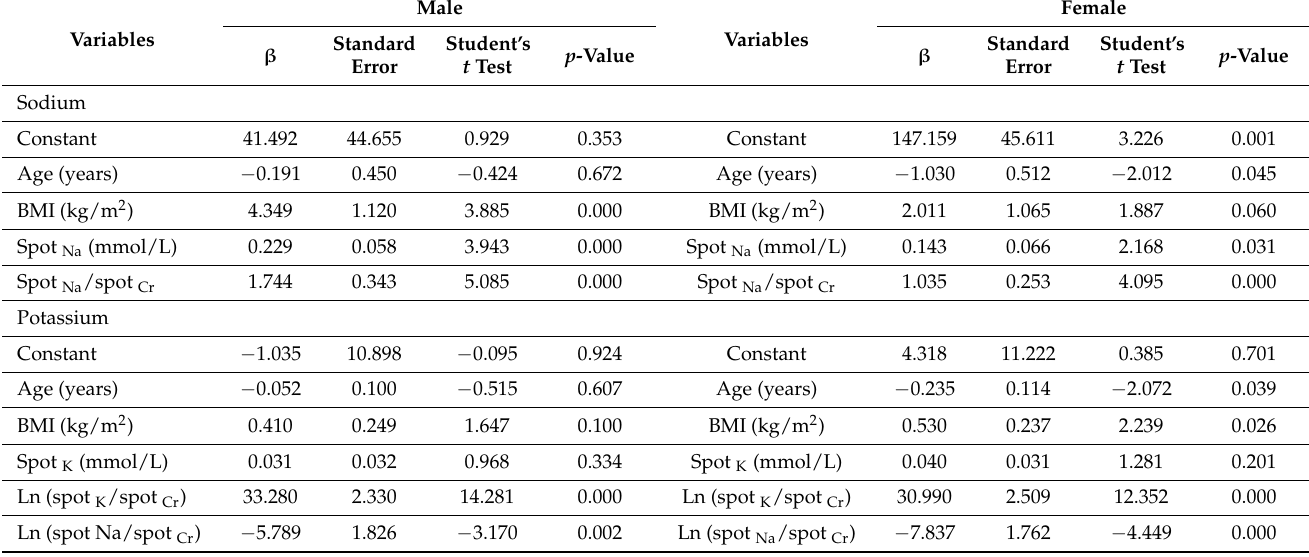
Table 2. Establishment of the equation for estimating 24UNaV and 24UKV from spot urine by multiple linear